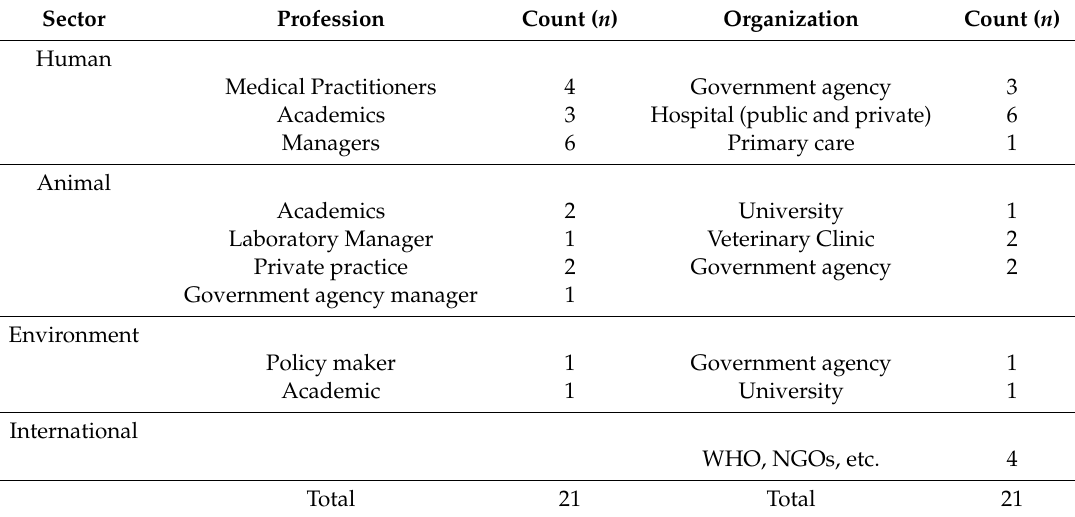
Table 1. Participants’ characteristics according to profession and